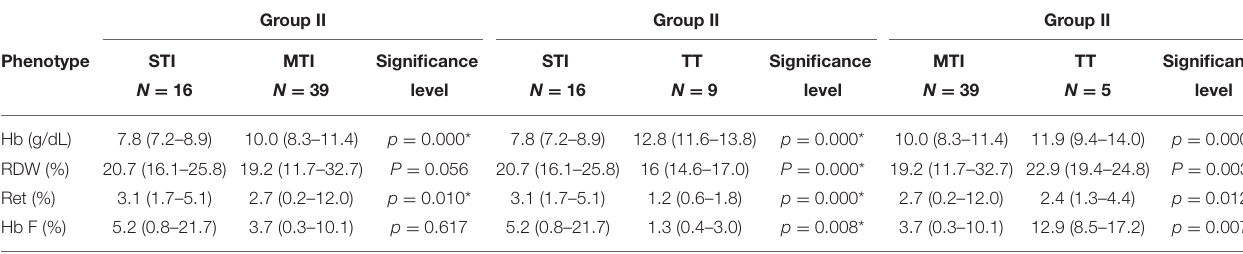
TABLE 5 | Comparison of means of the significant parameters within group II. Group II Group II Group II